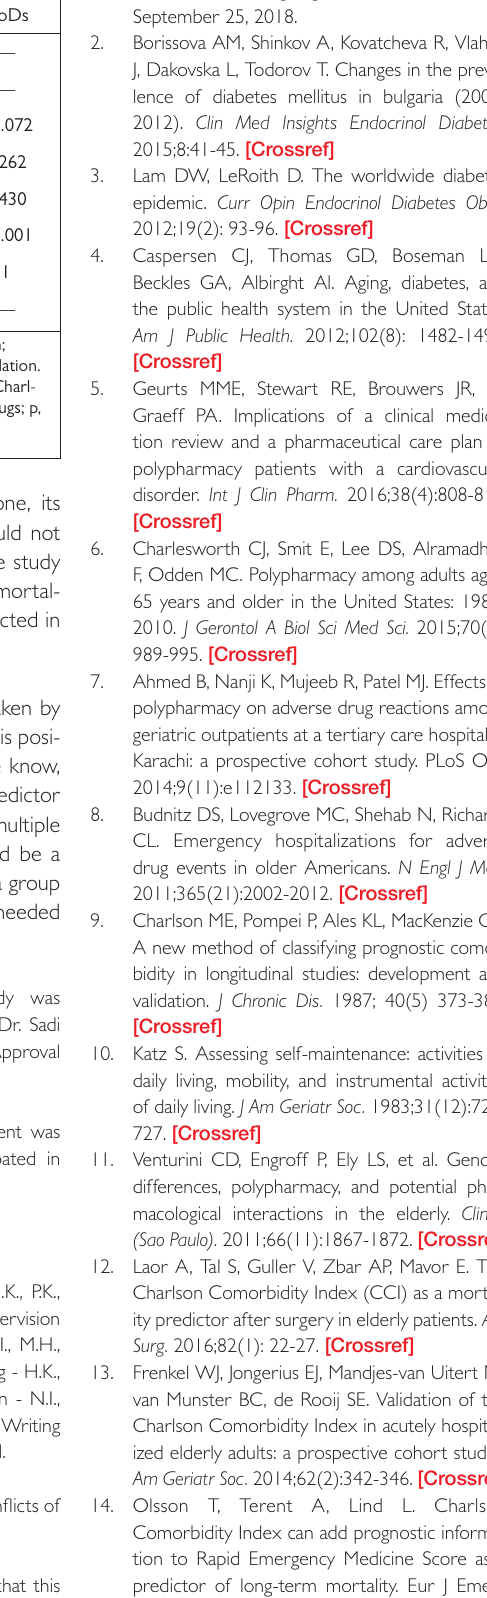
Table 4. Correlation Analysis Between Katz ADL, CCI, and Number of Drugs Taken by Participants in All Groups and Diabetic Group